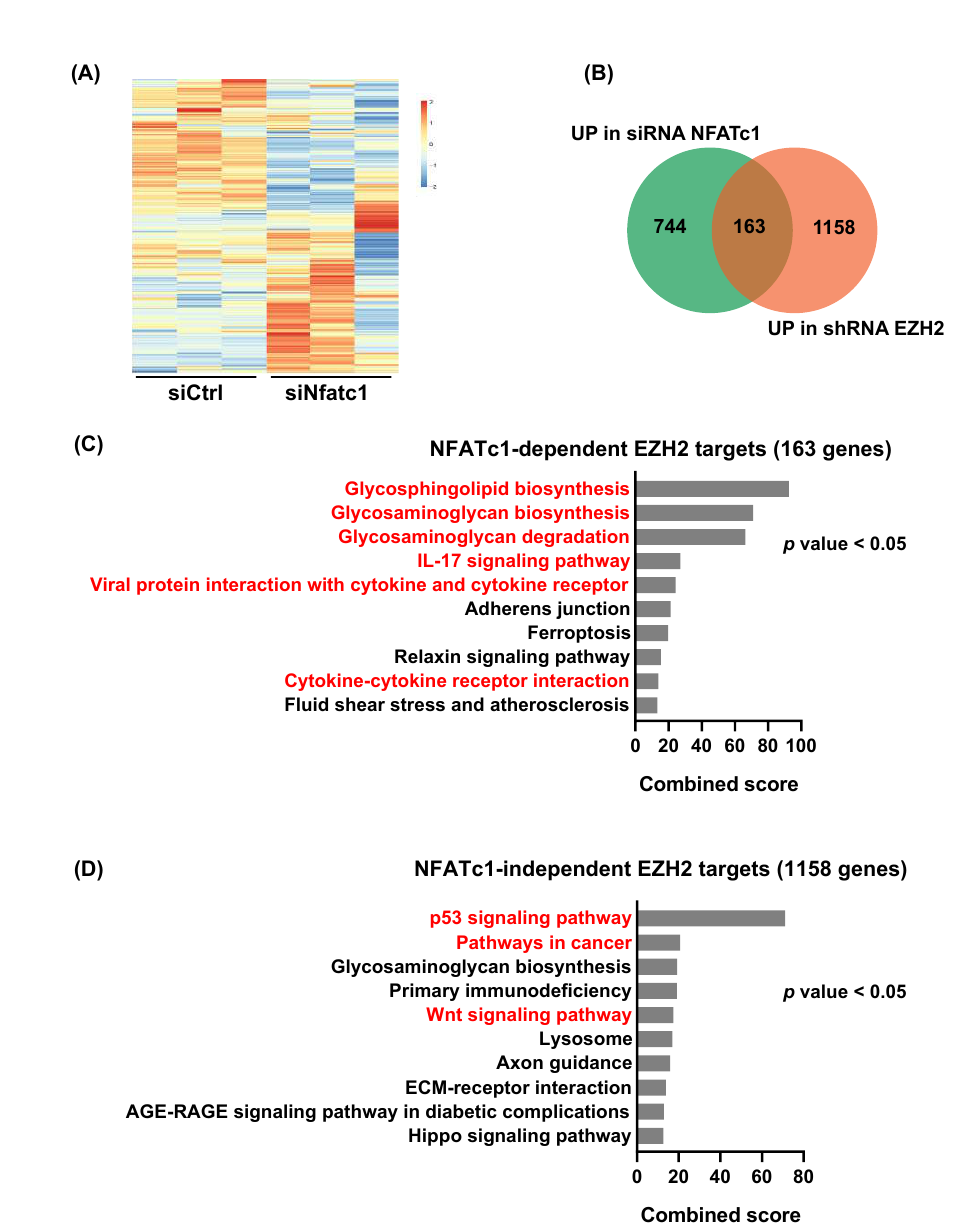
Figure 3. NFATc1 is involved in the regulation of a subset of EZH2-dependent gene signatures. ( A ) Heatmap illustrating NFATc1-dependent regulation of the subset of genes upregulated upon EZH2 knockdown as identified upon RNA-seq analysis in NKC-II cells (log2FC > 0.5, q value < 0.1, EZH2-repressed genes, n = 1321 genes) [7,19]. ( B ) A Venn diagram overlaying NFATc1- and EZH2- target genes found to be upregulated upon NFATc1- and EZH2-knockdown, respectively (log2FC > 0.5, q value < 0.1). The 163 overlapping target genes are considered as NFATc1 -dependent EZH2 targets. The 1158 genes upregulated only upon EZH2 knockdown are further referred to as NFATc1 - independent EZH2 target genes. ( C , D ) Pathway analysis of NFATc1 -dependent ( C ) and NFATc1- independent ( D ) EZH2 target genes using EnrichR. Enrichment was estimated based on combined score and the top 10 pathways were plotted. Distinct pathways in the groups of NFATc1-dependent and independent EZH2 targets are highlighted in red. p value < 0.05 were considered